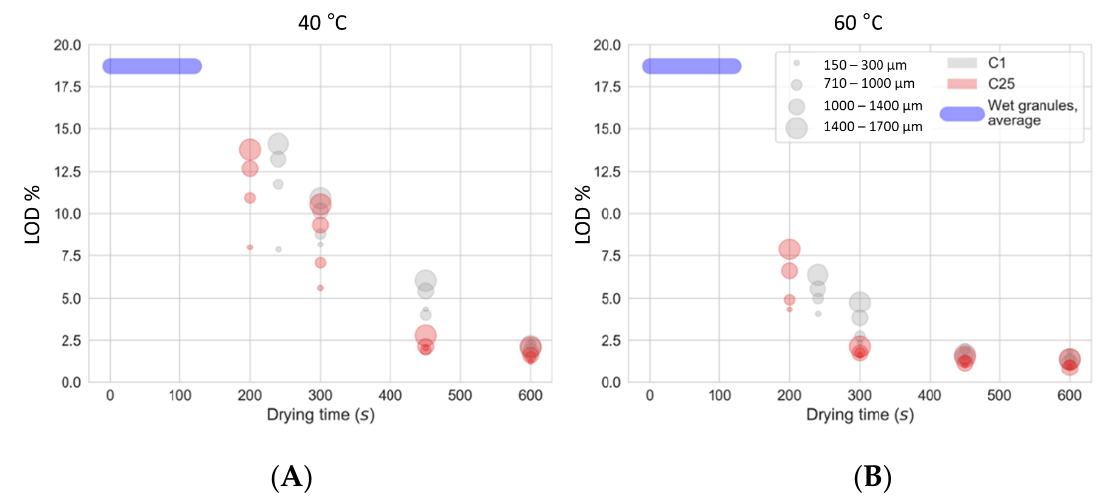
Figure 5. Residual moisture content (LOD values) of the granules produced on C1 and C25 in function of drying time at 40 ◦ C ( A ) and 60 ◦ C ( B ) for different size fractions (smaller size fractions are represented by smaller dots, whereas larger size fractions are represented by larger dots). The average moisture content of granules entering the drying cells during the filling phase was depicted by the blue bar.